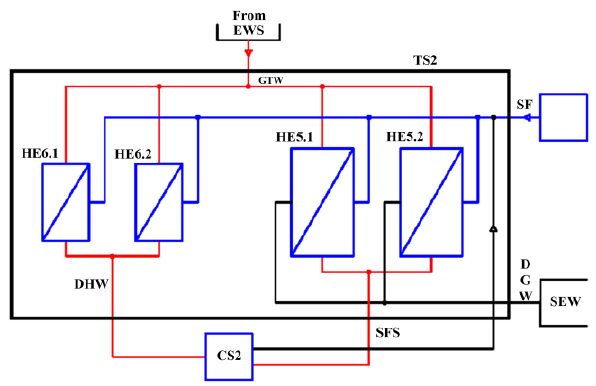
Figure 3. Second thermal station diagram (TS2).